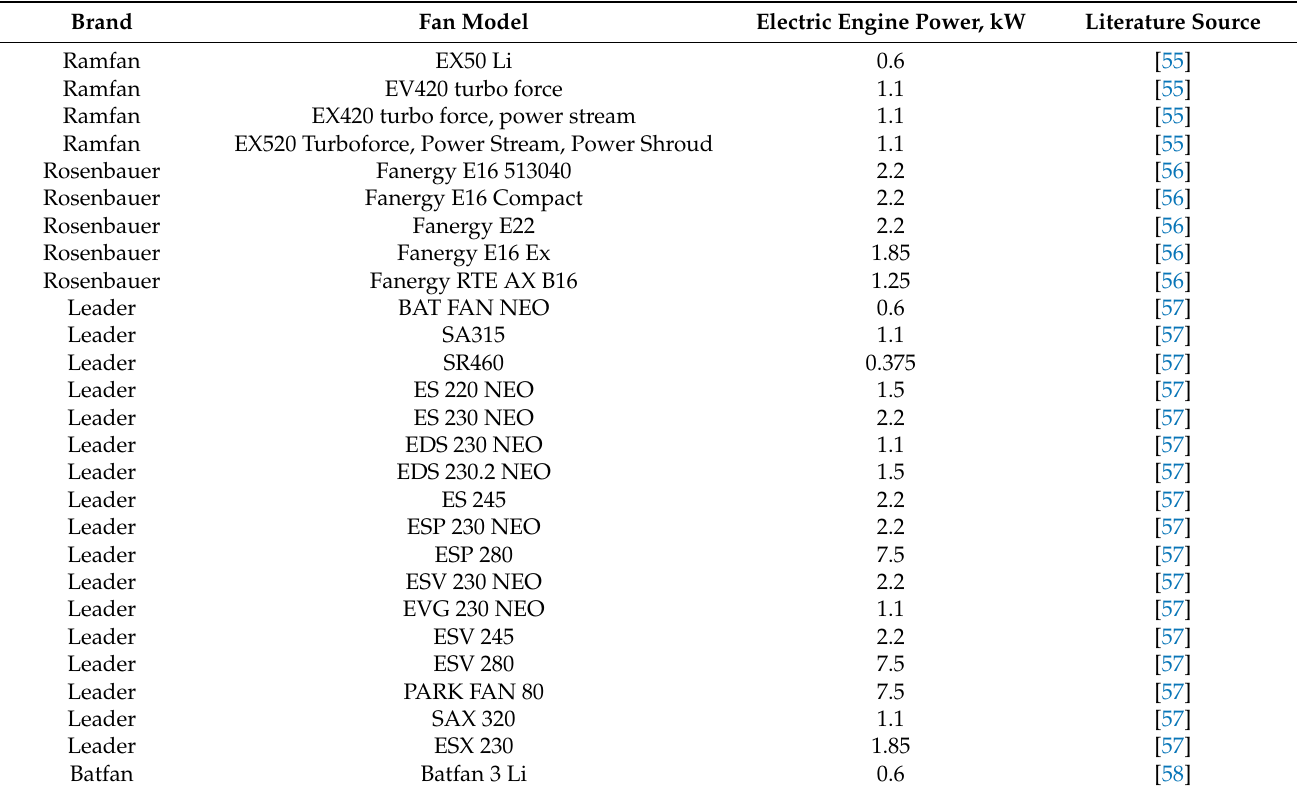
Table 1. Electric mobile positive pressure ventilation fans available on the European